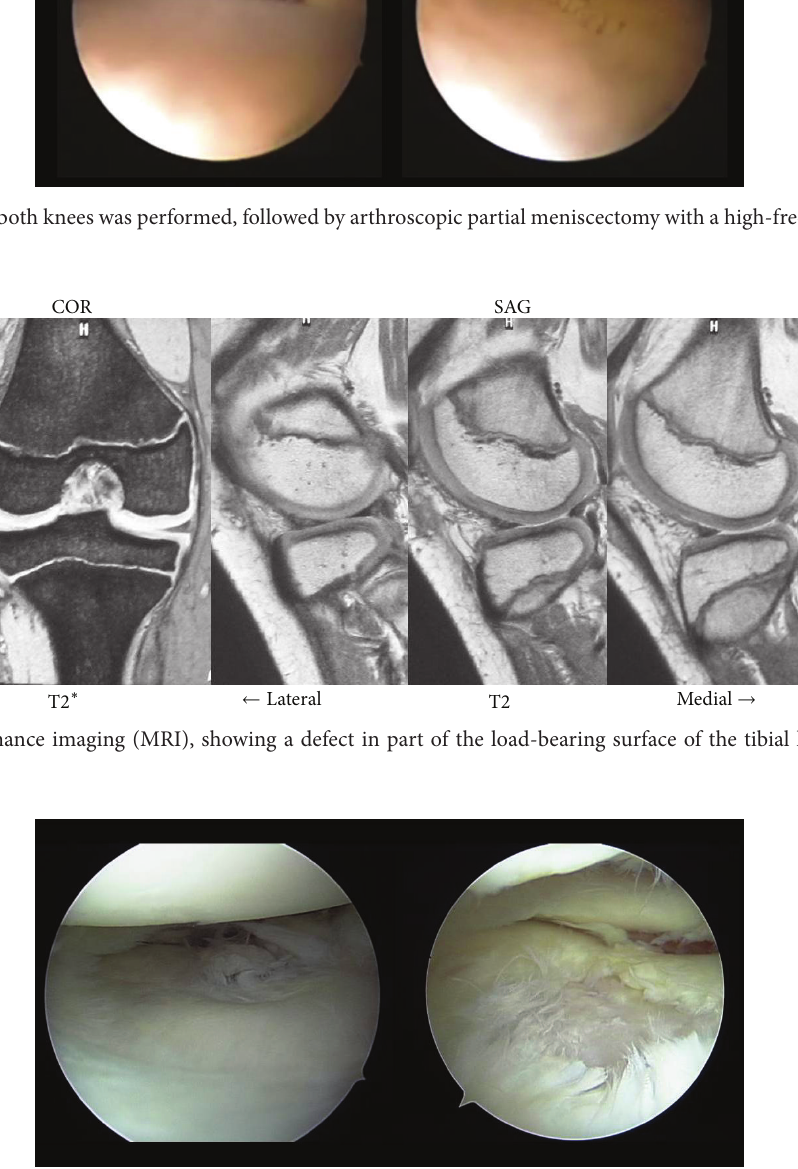
Figure 3: Arthroscopic findings: fibrillation was observed at the margin of the lateral meniscus after resection, and mild fibrillation of the femoral condyle cartilage was also present. A cartilage defect approximately 20 × 20 mm was observed in the load-bearing area of the tibial lateral condyle, and the subchondral bone was